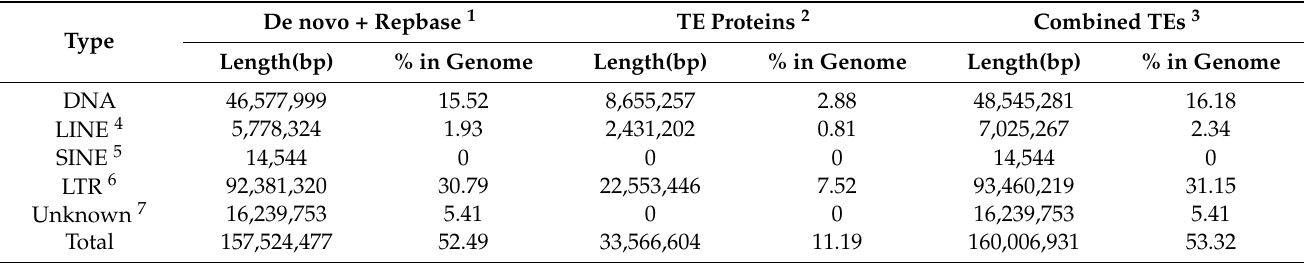
Table 2. Summary of repetitive sequences in the genome of P. campanulata .